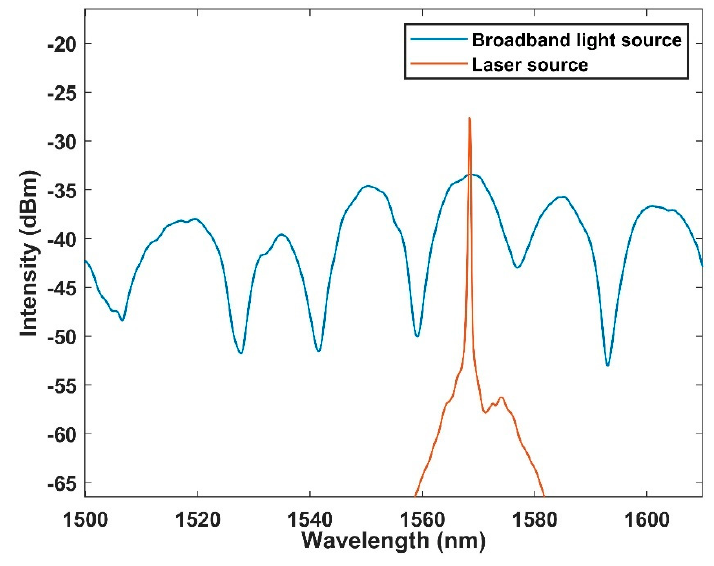
Figure 9. Fitting diagram of interference spectrum and laser spectrum.